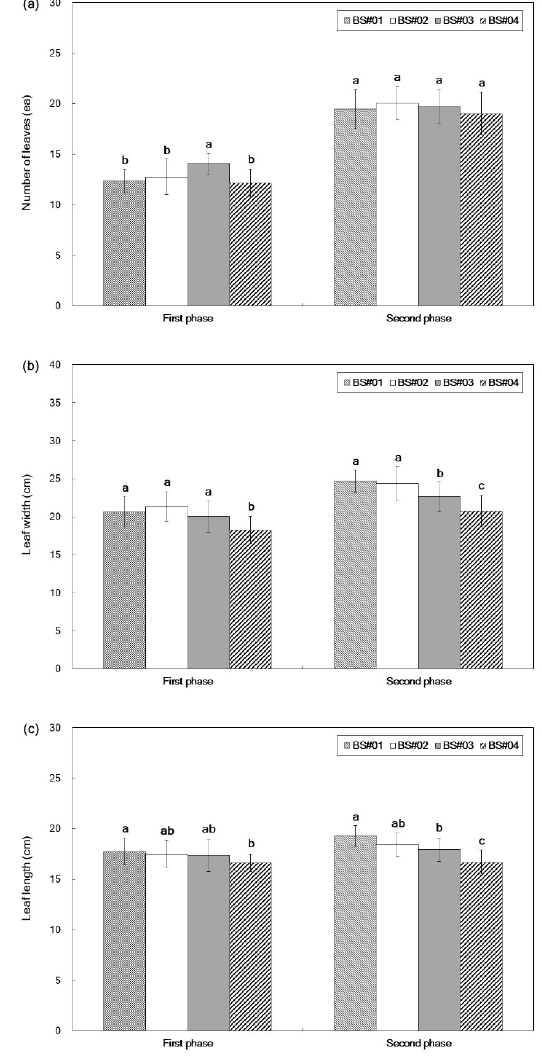
Figure 3. Effect of saline irrigation water on ( a ) number of leaves, ( b ) leaf width, and ( c ) leaf length. Bars represent the mean ± standard deviation, n = 20. Different letters indicate significant differences among treatments by Tukey’s honest significant difference test at p < 0.05. BS: before water treatment using the BWD system, i.e., saline water irrigation.